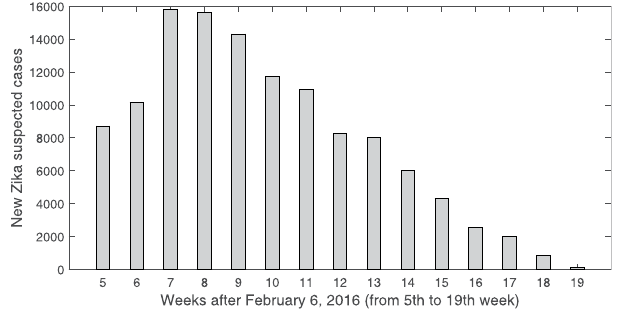
Figure 1. Reported suspected Zika cases in Brazil from February 6 to June 2,